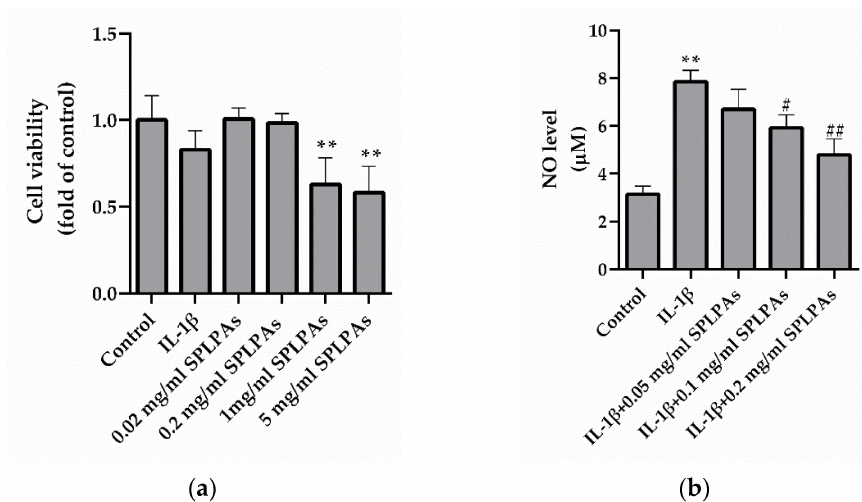
Figure 2. Cytotoxic and NO-inhibitory effect of SPLPA extract. ( a ): Cytotoxic effect of SPLPAs extract at 0.02–5 mg/mL. ( b ): NO inhibitory effect of SPLPAs extract at 0.02 to 0.2 mg/mL. ** p < 0.01 vs. the control group. ** p < 0.01 vs. the control group. # p < 0.05 and ## p < 0.01 vs. the IL-1 β (10 ng/mL) group.